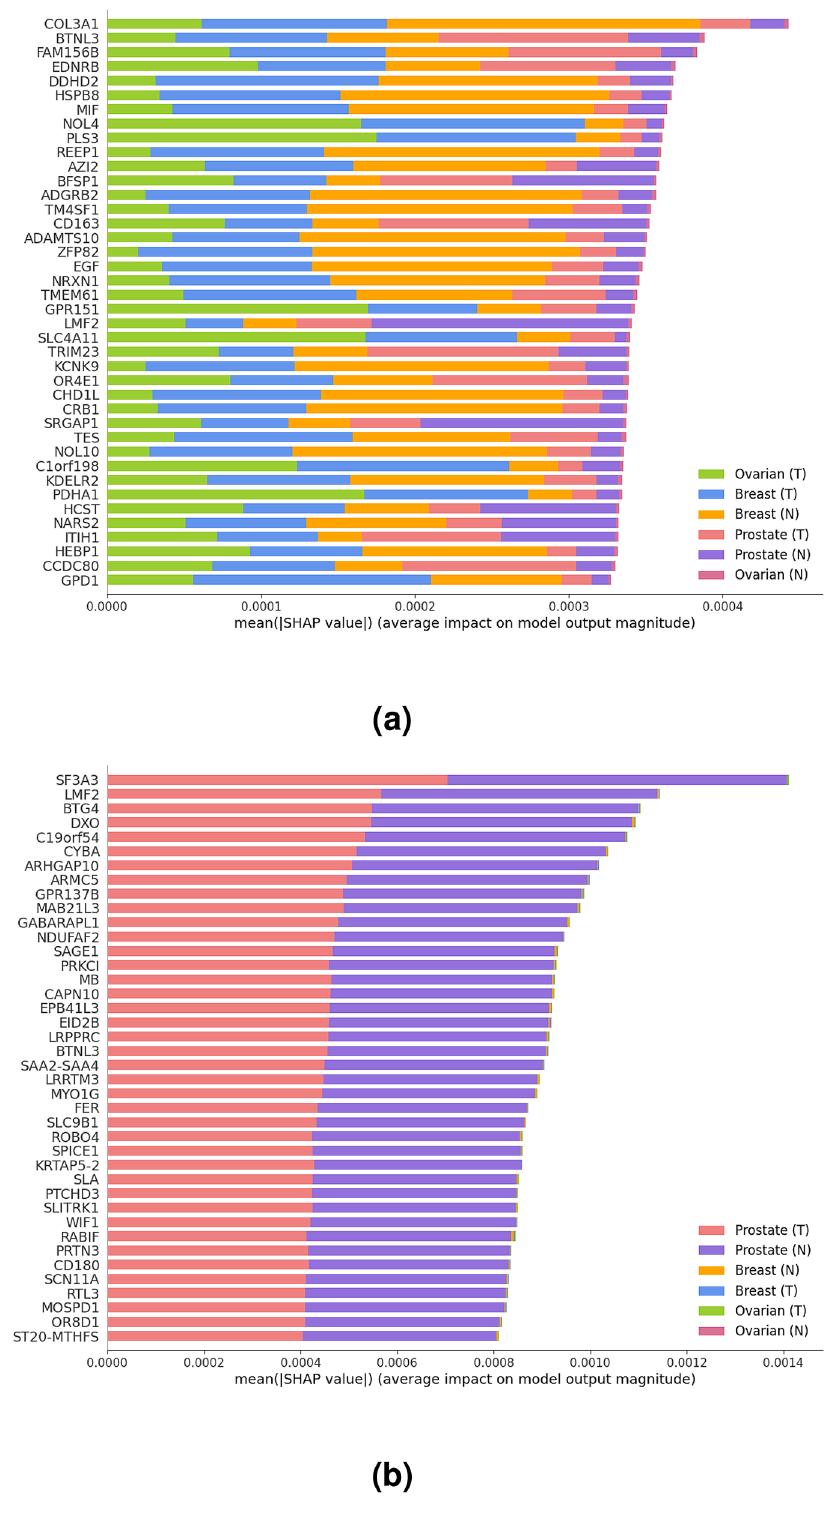
Figure 8. The most relevant genes for patients with advanced PCa identified by SHAP ordered based on ( a ) the total contribution scores of the three tissues and disease states (top CC ALL), and ( b ) contribution scores identified solely based on the prostate tissue and its disease state (top CC